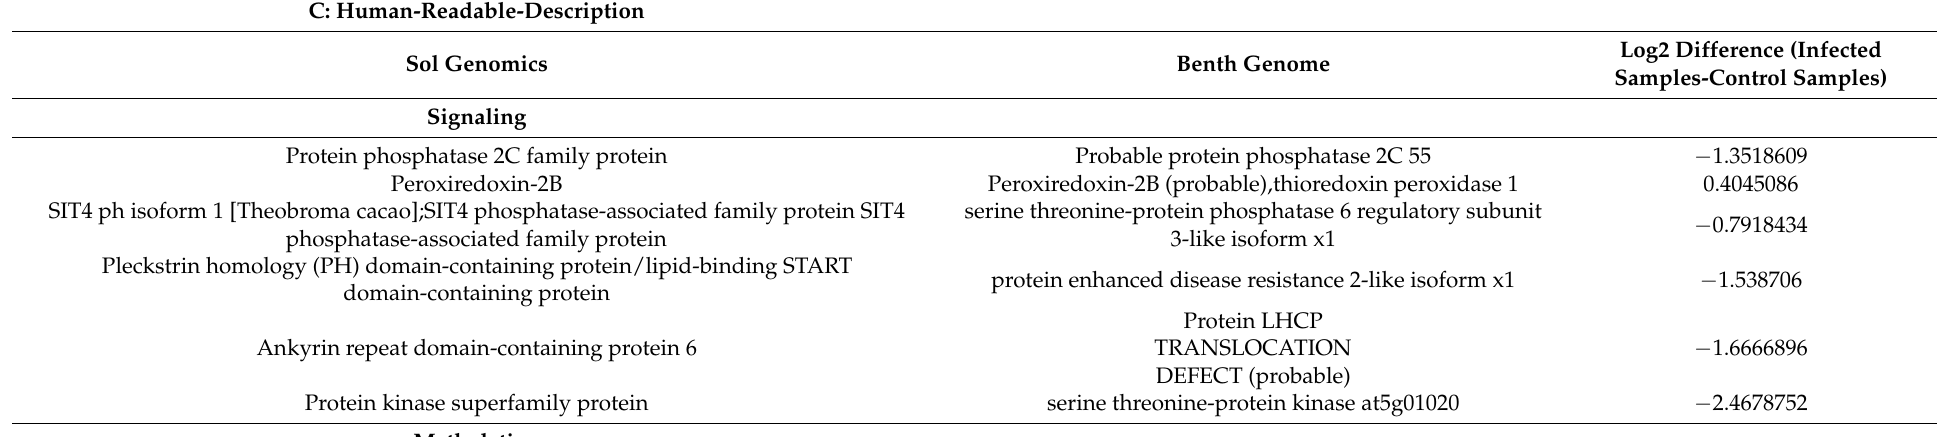
Table 4. List of Identified Proteins Affected During Viroid Infection. C: